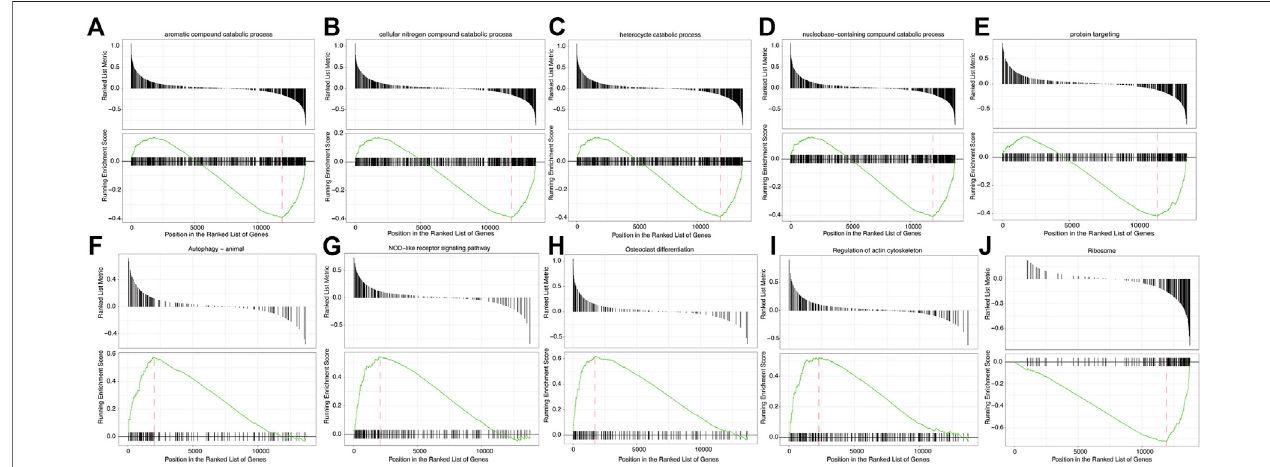
FIGURE 7 | Gene Set Enrichment Analysis (GSEA). (A – J) GSEA enrichment analysis result sub-graph. The upper part of the graph represents the distribution of rank values of all genes after sorting, and the Signal2Noise algorithm is used by default. The lower part of the graph represents the line chart of the gene Enrichment Score, the horizontal axis is each gene in the gene set, and the vertical axis is the corresponding